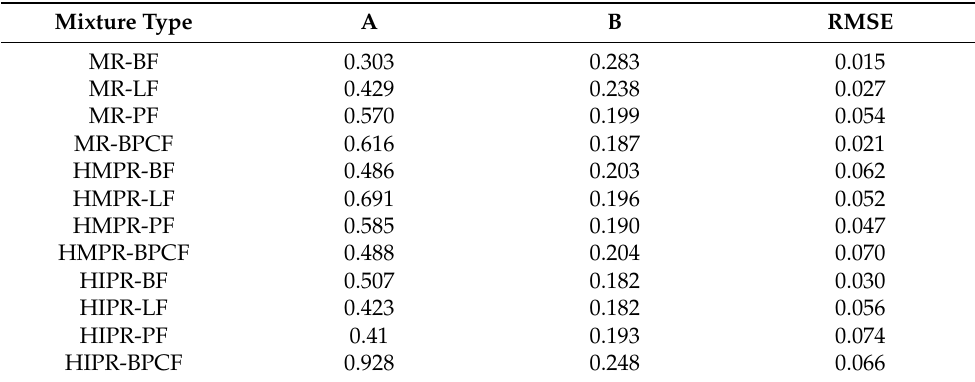
Table 11. Fitting parameters of the negative curvature phase.